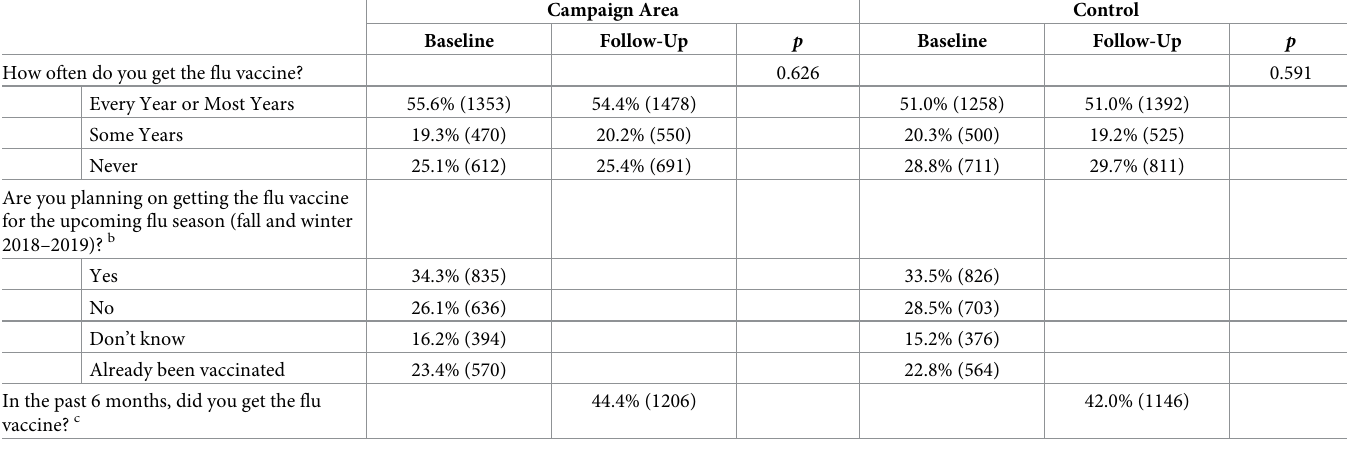
Table 2. Previous flu and vaccine history at baseline and follow-up, campaign area versus control a